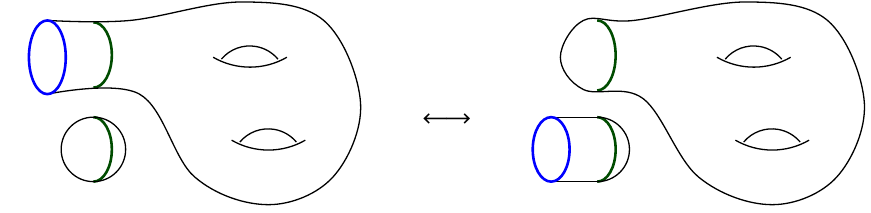
Figure 4: Surgery around a boundary component for a trivial bulk